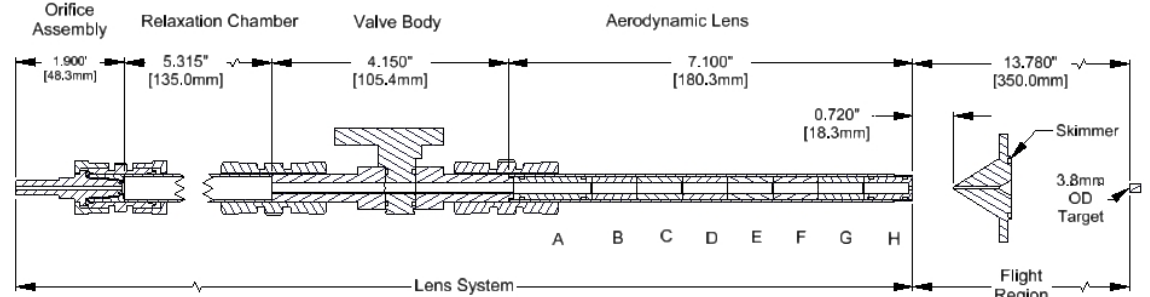
Fig. 1. Schematic of the lens system, including critical orifice assembly, relaxation chamber, valve and aerodynamic lens, and flight region to the vaporizer/target for the high-pressure lens in an aerosol mass spectrometer (not to